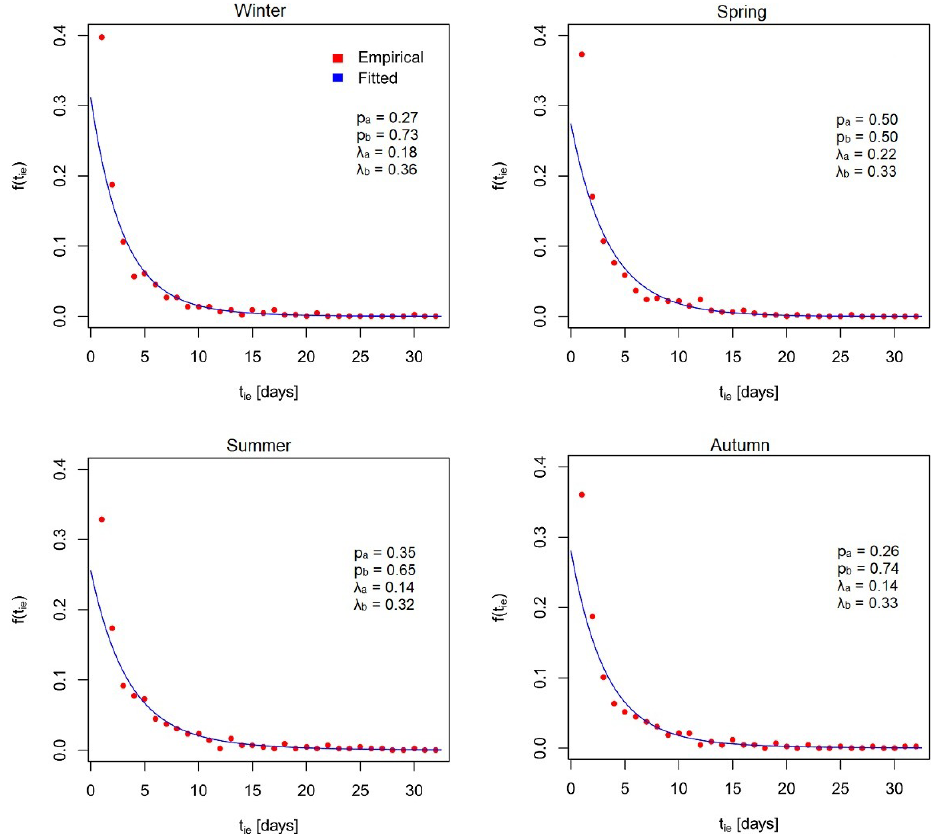
Figure 1. Fitted two-component mixed exponential distributions to seasonal empirical probabilities of observed (Uccle) dry event durations. λ a , ie and λ b , ie are the rate parameters for populations a and b with different exponential distributions. p a is the weight of population a, and p b is the complement of the weight of population a (p b = [ 1 − p a ] ) .